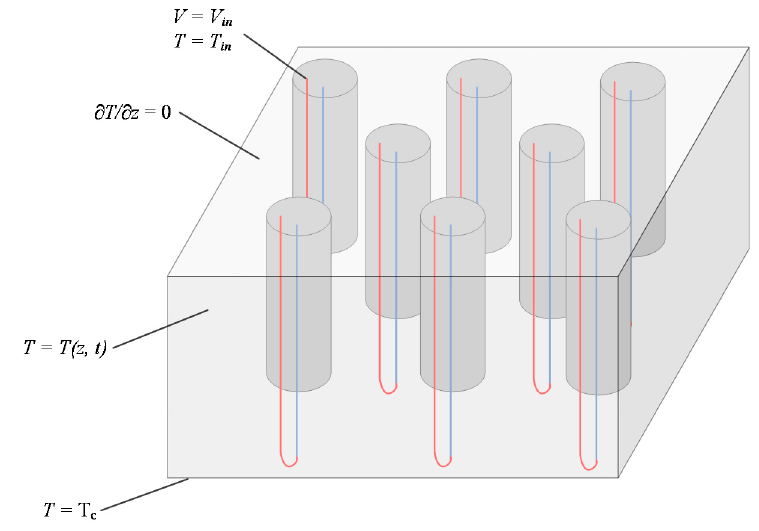
Figure 3. Boundary and initial conditions employed in the numerical